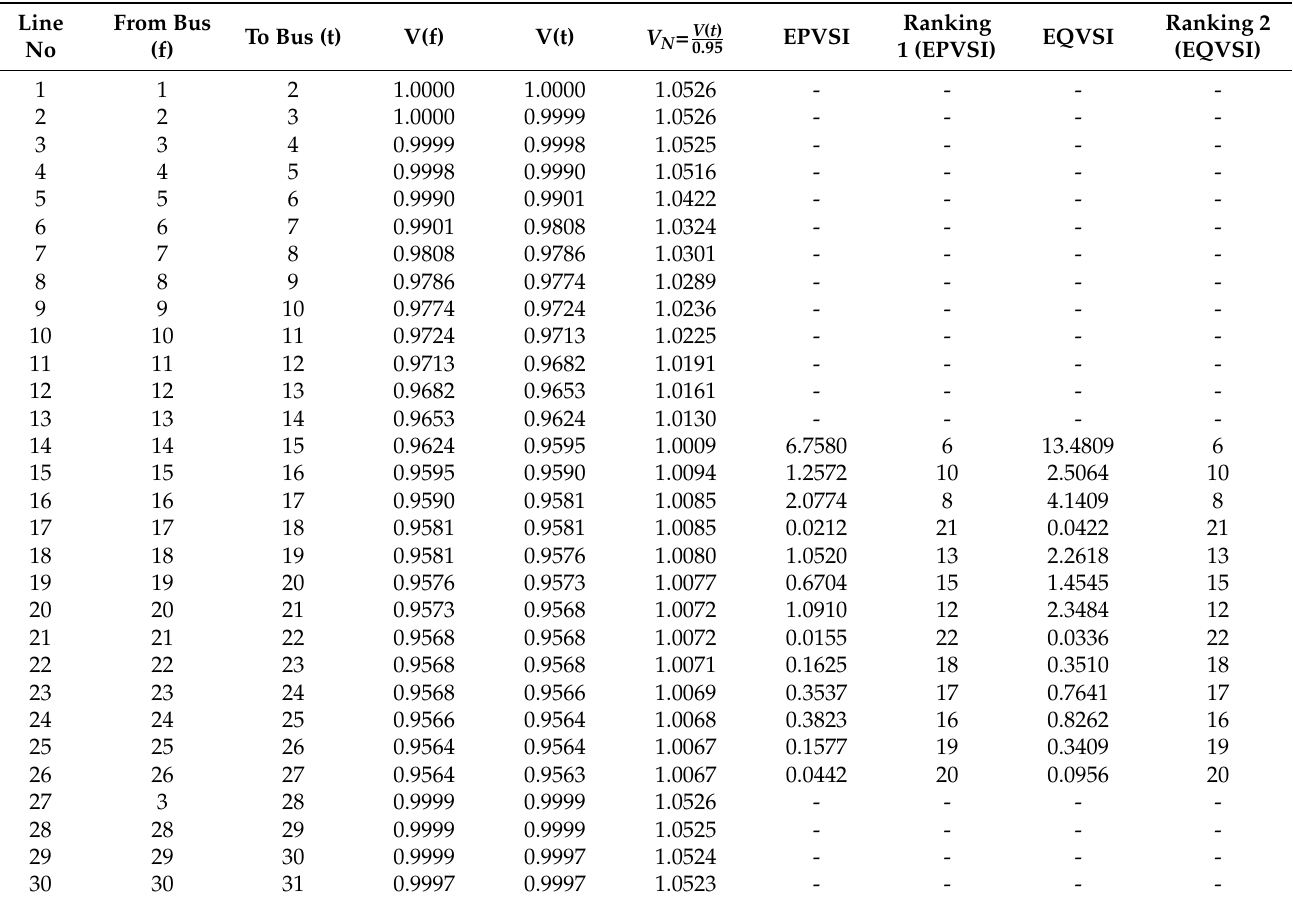
Table 5. Results of EPVSI and EQVSI for IEEE 69-bus